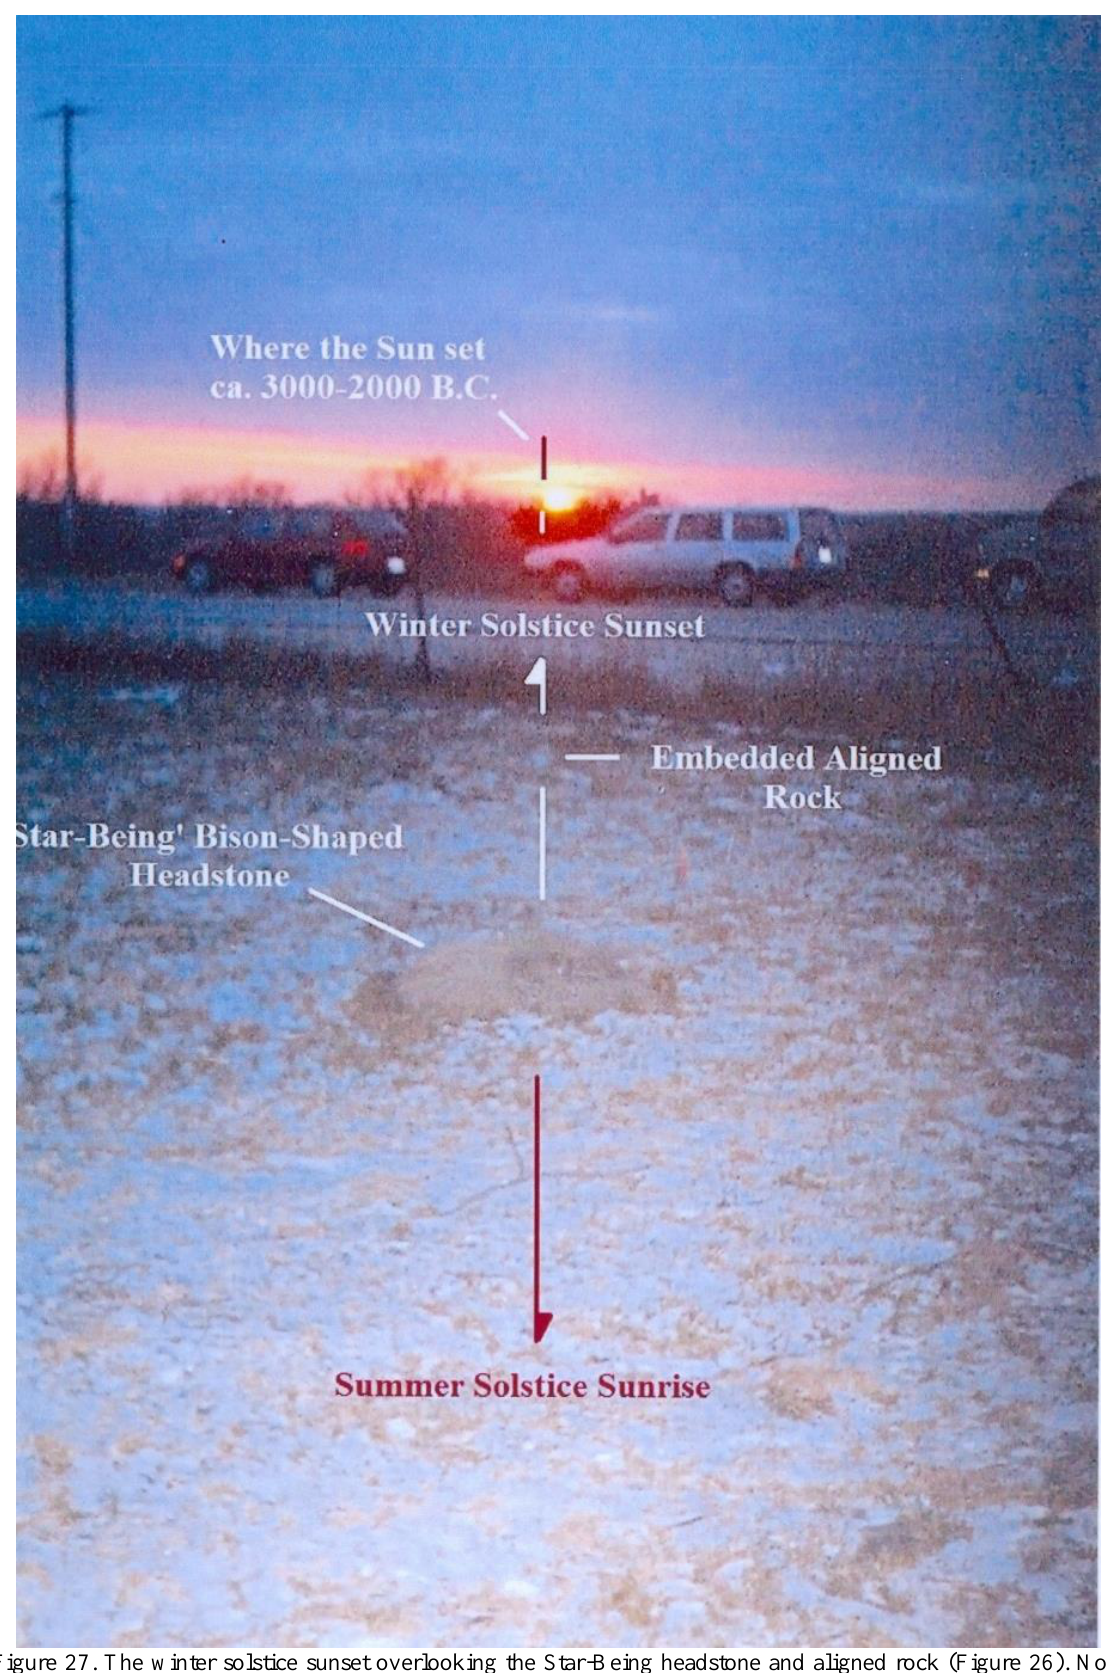
Figure 27. The winter solstice sunset overlooking the Star-Being headstone and aligned rock (Figure 26). Note the full solar diameter shift to the right or north of the alignment, which is the effect of 4000 years of the shift of obliquity of the